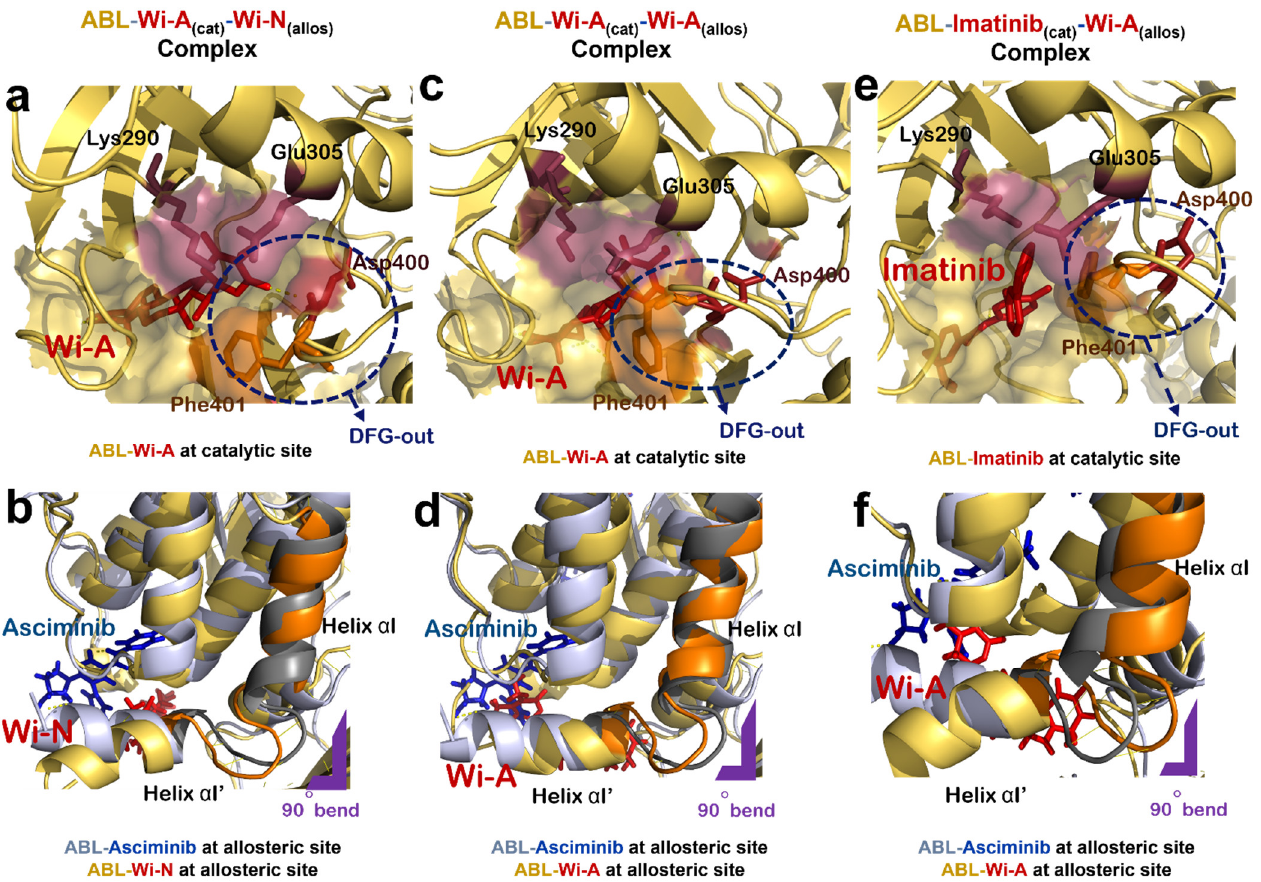
Figure 3. Effect of natural compounds on catalytic and allosteric site of ABL protein dimer. ( a ) In- teraction of Wi-A at catalytic site of ABL-Wi-A (cat) -Wi-N (allos) complex (ABL in yellow, Wi-A in red). ( b ) Superimposed structure of allosteric site of ABL-Imatinib (cat) -Asciminib (allos) complex (ABL in grey, Asciminib in blue) with that of ABL-Wi-A (cat) -Wi-N (allos) complex (ABL in yellow, Wi-N in red). ( c ) Interaction of Wi-A at catalytic site of of ABL-Wi-A (cat) -Wi-A (allos) complex (ABL in yellow, Wi-A in red). ( d ) Superimposed structure of allosteric site of ABL-Imatinib (cat) -Asciminib (allos) complex (ABL in grey, Asciminib in blue) with that of ABL-Wi-A (cat) -Wi-A (allos) complex (ABL in yellow, Wi-A in red). ( e ) Interaction of Imatinib at catalytic site of ABL-Imatinib (cat) -Wi-A (allos) complex (ABL in yellow, Imatinib in red). ( f ) Superimposed structure of allosteric site of ABL-Imatinib (cat) -Asciminib (allos) complex (ABL in grey, Asciminib in blue) with that of Abl-Imatinib (cat) -Wi-A (allos) complex (ABL in yellow, Wi-A in red).